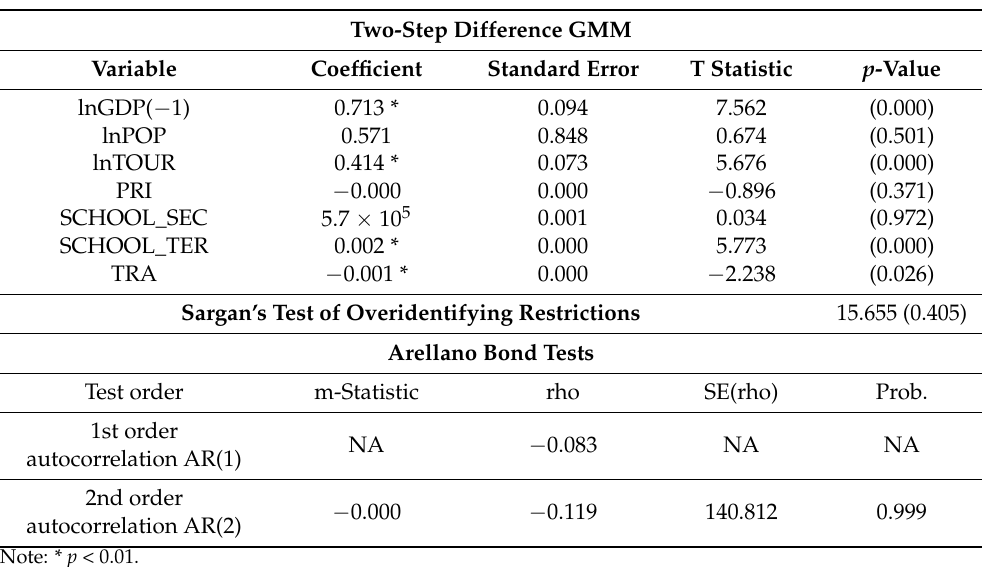
Table 4. Two-step difference in GMM